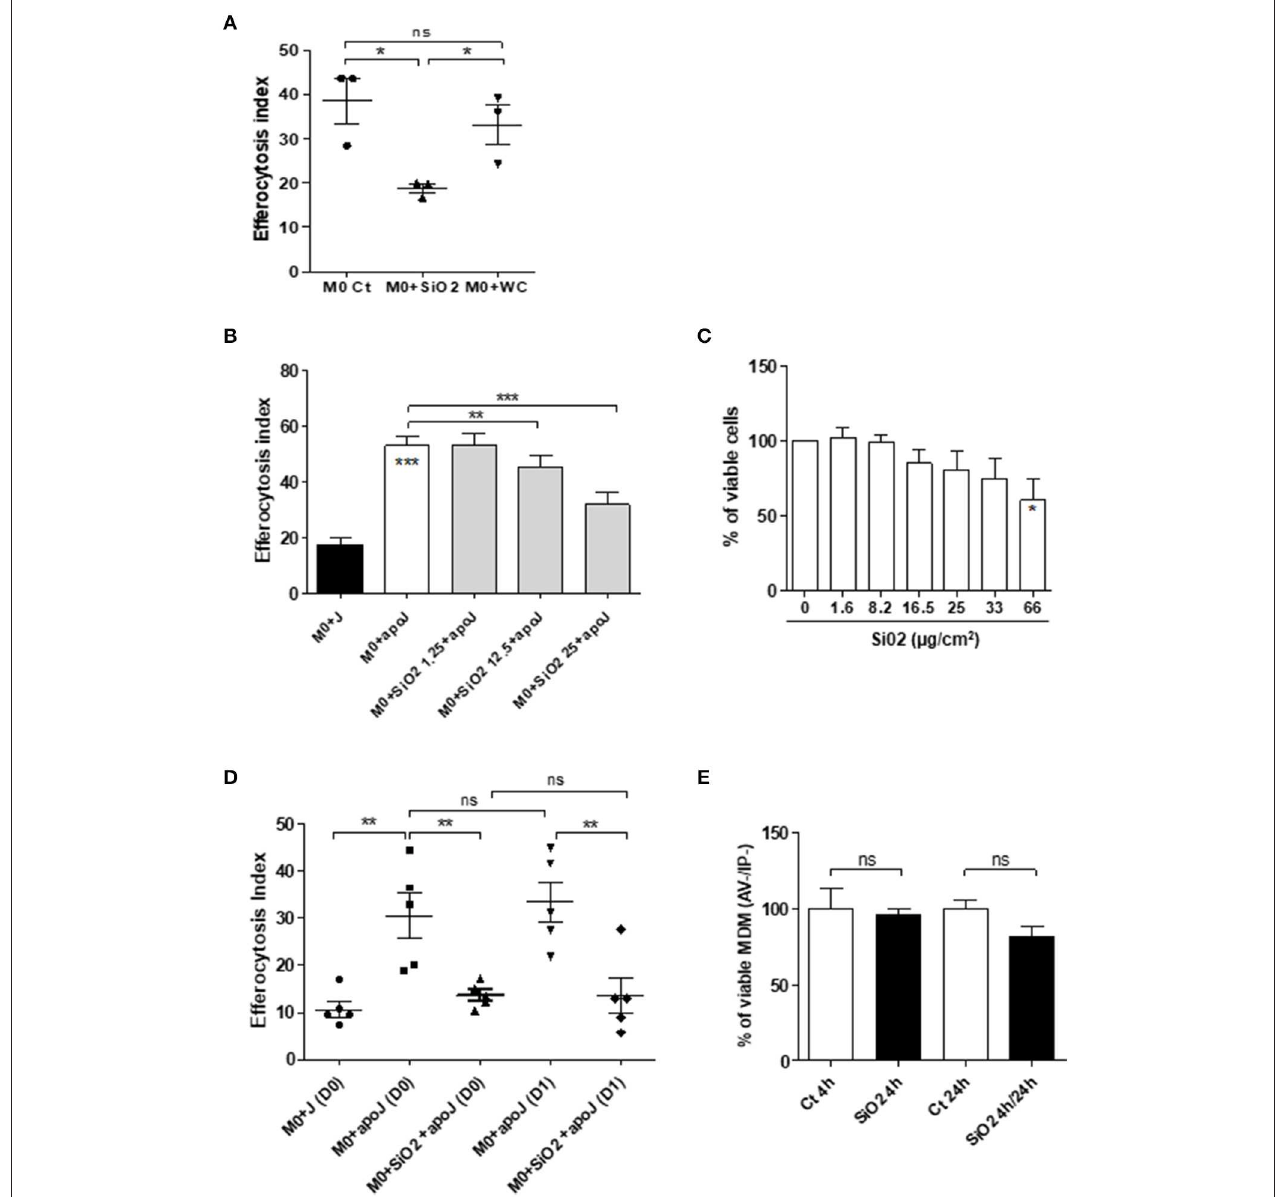
FIGURE 2 | Impaired efferocytosis capacities of silica-exposed MDM in vitro is specific, dose dependent, irreversible and is not directly due to the impact of SiO 2 on cell viability. (A) EI of M0 MDM from the same healthy donors, untreated or treated by 25 µ g/cm 2 of SiO 2 or WC for 4h and then exposed to apoptotic Jurkat (apoJ) or live Jurkat (J) cells (Experiment on MDM from 3 different healthy donors). (B) EI of M0 MDM from the same healthy donors, untreated or treated by the indicated concentrations of SiO 2 for 4h and then exposed to apoptotic Jurkat (apoJ) (Experiment on MDM from 3 different healthy donors). (C) Determination of MDM cell viability by a WST-1 assay; data expressed in percentage of viable cells (Experiment on MDM from 4 different healthy donors). (D) EI of M0 MDM untreated or treated with 25 µ g/cm 2 of SiO 2 for 4h, washed and then exposed to apoptotic Jurkat (apoJ) or live Jurkat (J) cells for 90min the same day (D0) or 24h later (D1) (Experiment on MDM from 5 different healthy donors). (E) Determination, by flow cytometry, of MDM cell viability by AV/IP staining after exposure to 25 µ g/cm 2 of SiO 2 for 4h only or, 4h followed by a 24h period without SiO 2 (Experiment on MDM from 4 different healthy donors). * p < 0.05; ** p < 0.01; *** p < 0.001; ns, not